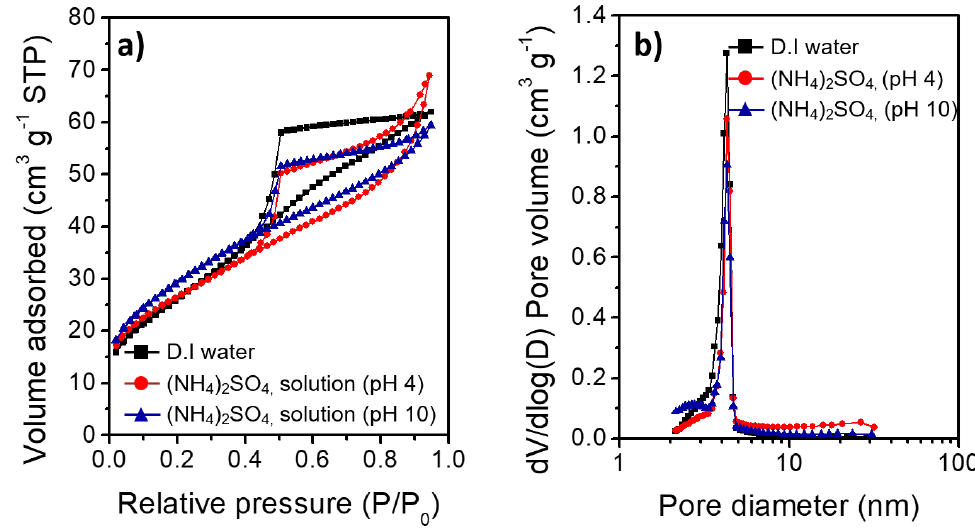
Figure 5. XRD patterns of the Al@AlOOH core–shell samples prepared by HTR in D.I. water and aqueous solution of (NH 4 ) 2 SO 4 at different pHs of 4.0 and 10.1 ( a ) and the Al@Al 2 O 3 core–shell obtained by calcination of the Al@AlOOH samples at 823 K for 4 h ( b ). Nanomaterials 2020 , 10 , x FOR PEER REVIEW 10 of 13